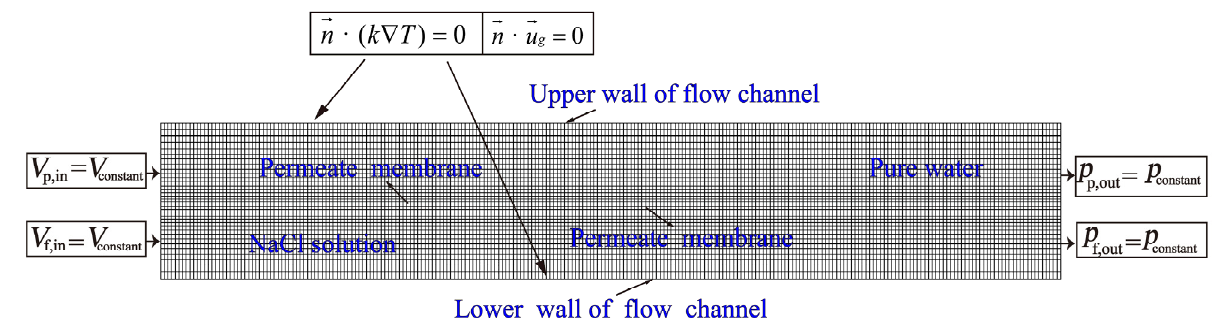
Figure 2. Schematic diagram of specific meshing results and boundary